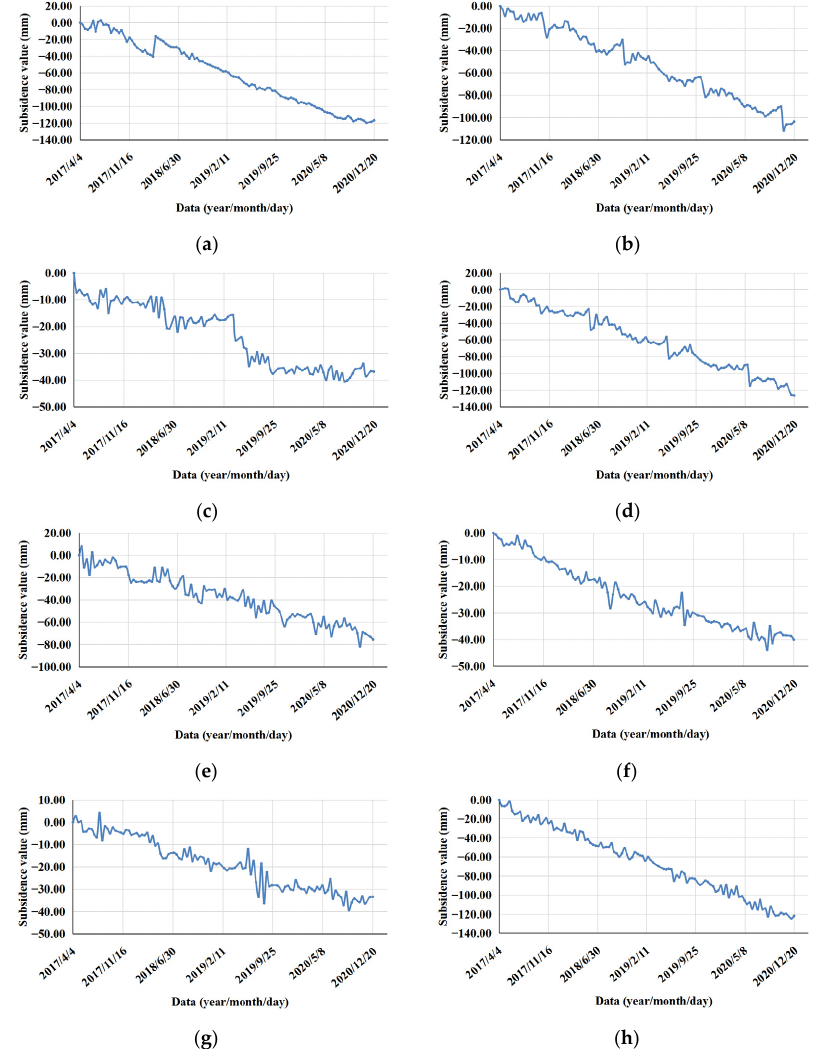
Figure 9. The deformation time curve of the maximum subsidence point in each area: ( a ) Area A; ( b ) Area B; ( c ) Area C; ( d ) Area D; ( e ) Area E; ( f ) Area F; ( g ) Area G; and ( h ) Area H. Combined with the geographic location information, the above local typical subsid- ence areas were summarized into three categories for discussion and analysis [31]: Area A (area along the subway), Area B (area containing a large logistics company), and Areas